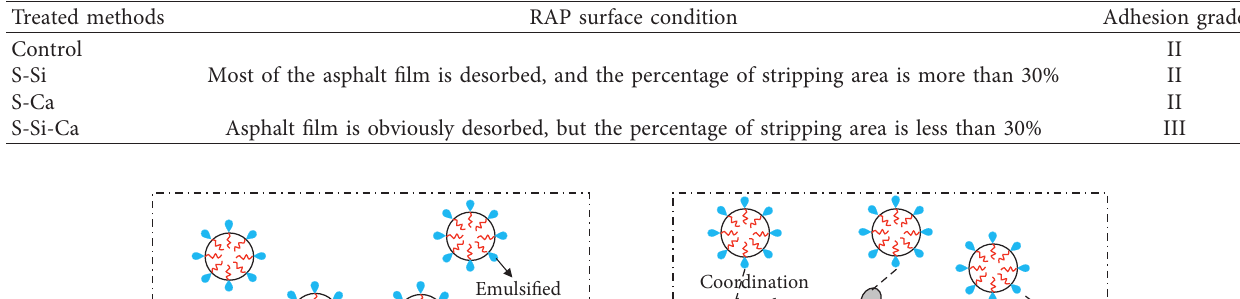
Figure 11: The adhesion grade test for emulsified asphalt and RAP. Table 7: Adhesion results of emulsified asphalt and RAP.